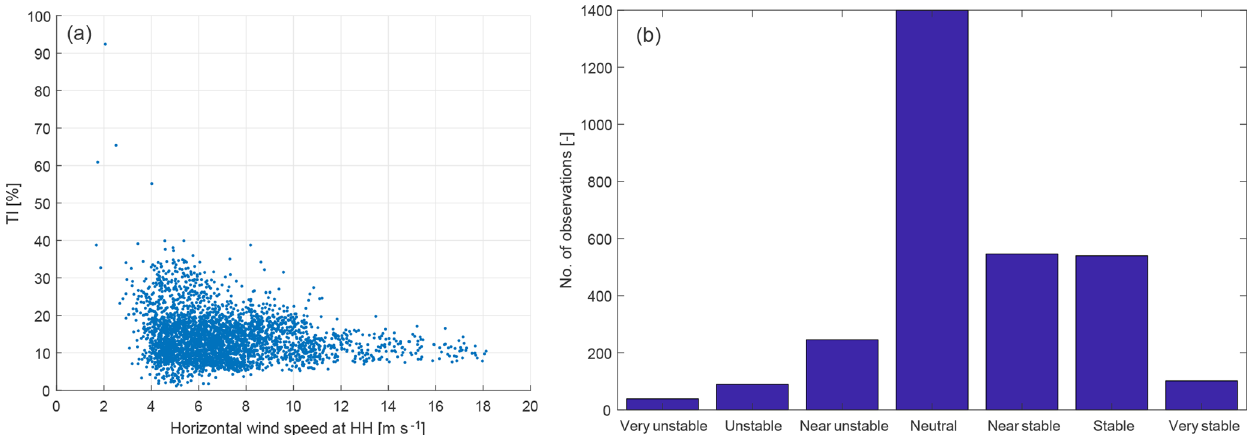
Figure 4. Hub height turbulence intensity versus wind speed (a) and count of the stability classes (b) .